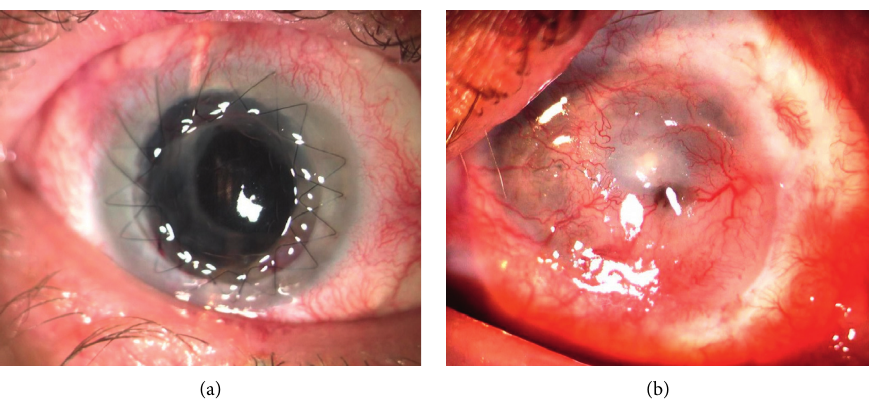
Figure 1: (a). Successful keratoplasty after KLAL with double running suture without vascular invasion crossing limbal border of the KLAL graft. (b) Total failure—superficial and deep vascular ingrowth into corneal bottom after PK with partial melting of both